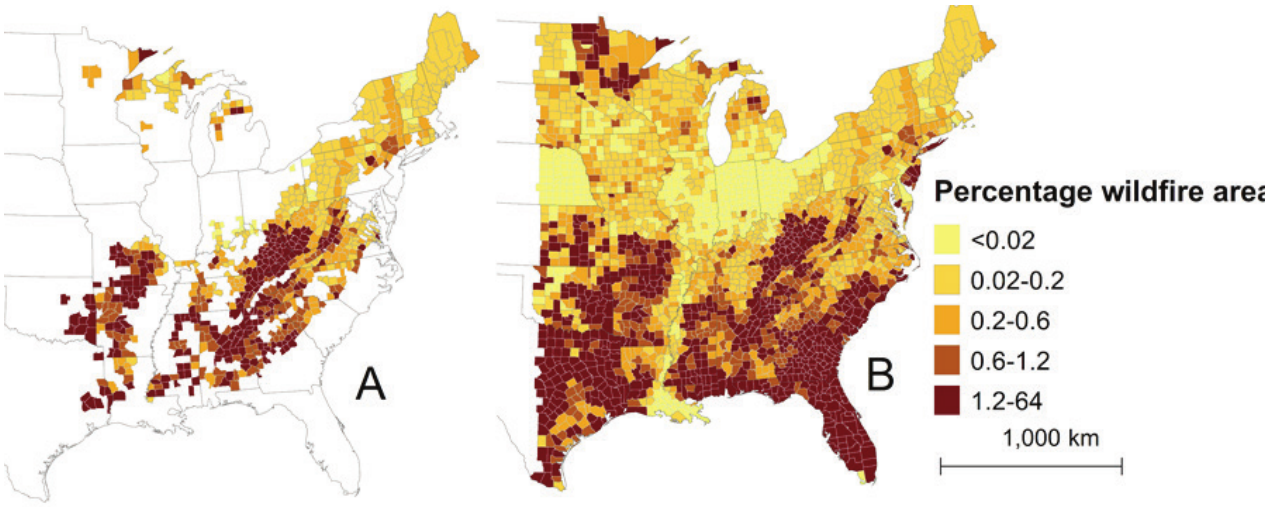
Landscape Online – supported by the International Association for Landscape Ecology and its community